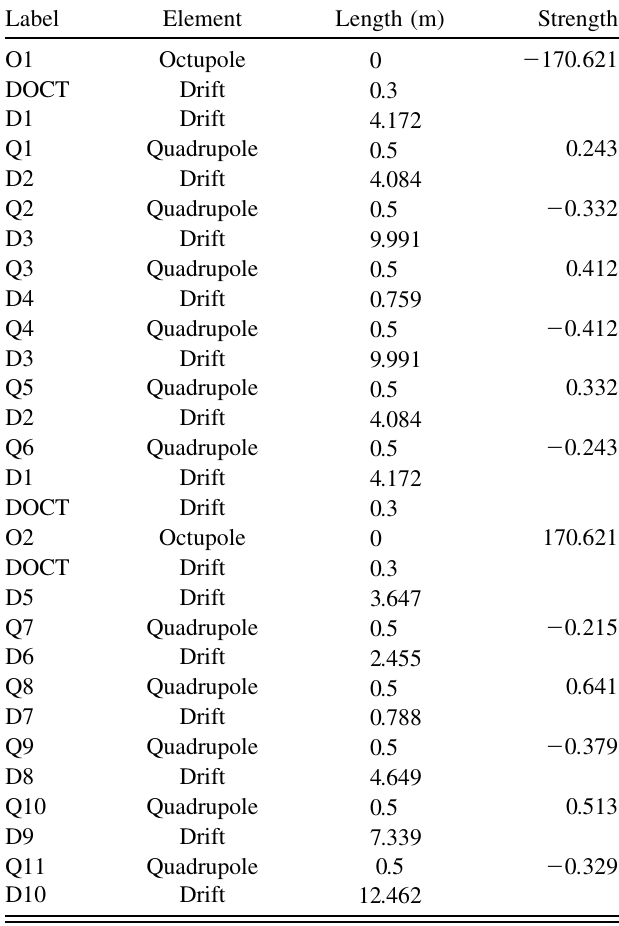
TABLE II. The lattice